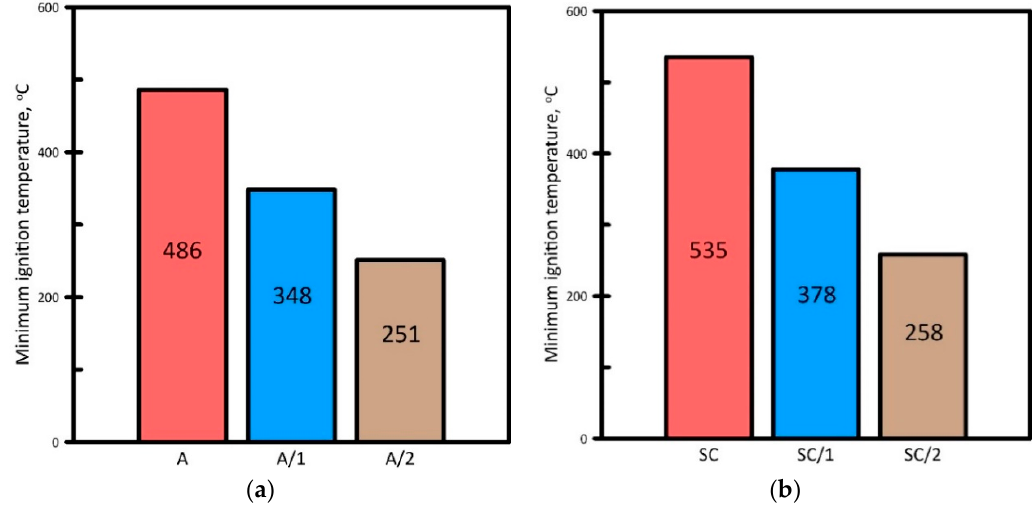
Figure 4. The dependencies of the ignition delay time on the temperature of heating medium for the samples of anthracite ( a ) and semi ‐ coke ( b ).